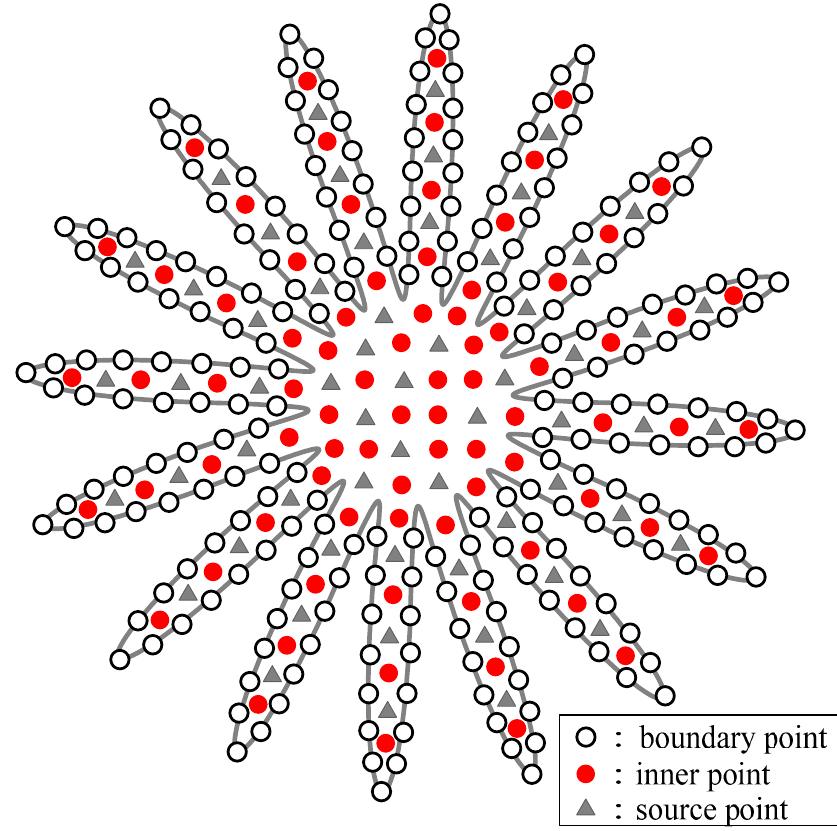
Figure 4. Layout of boundary, source and inner points.